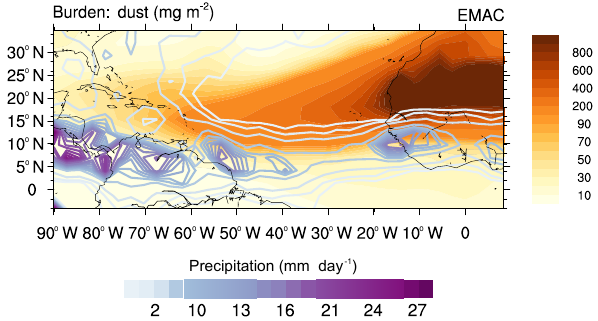
Figure 5. The EMAC computed spatial distribution of the dust bur- den (orange) and total precipitation (purple lines) for the reference simulation for July 2009 (monthly